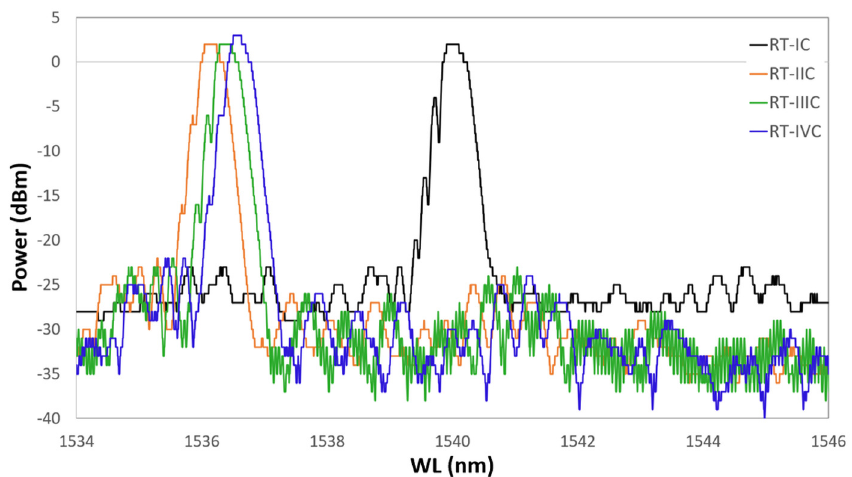
Figure 12. Grating spectrum at the wavelength corresponding to the RT measured at the beginning of each cycle. In black is shown the first cycle, in red the second, in green the third, and in blue the fourth. The black plot represents the grating spectrum as it was 24 h after the Cu coating, and it is defined as the first heating cycle. For each spectrum, the sample is recorded while at RT, just before starting the heating which brings it up to 700 ◦ C. In red is shown the RT spectrum at the beginning of the second cycle, in green the spectrum at the beginning of the third cycle, and finally, in blue the spectrum shown at the beginning of the fourth cycle. During tests, the RT value was around 21 ± 1 ◦ C for each cycle. The four frames of Figure 13 show four spectra of the same grating grouped by temperature